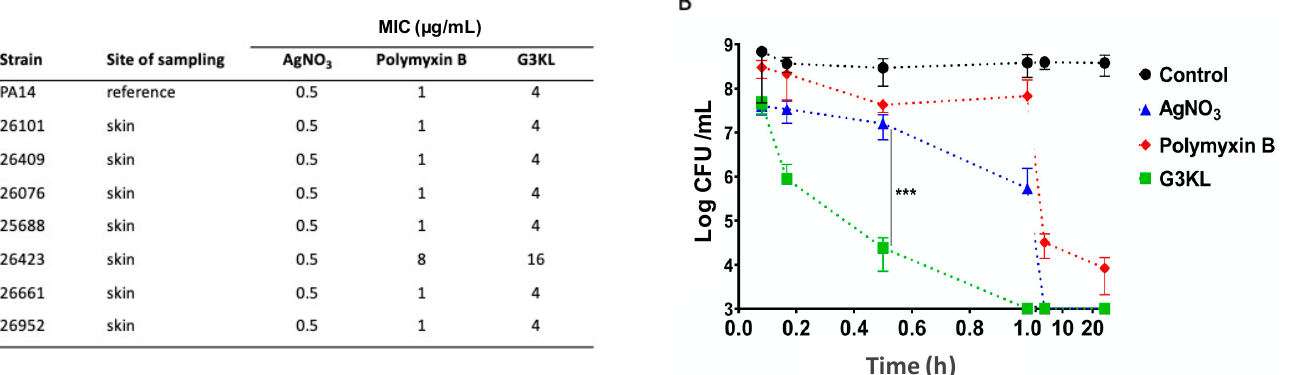
Figure 2. Antibacterial activity of G3KL. ( A ) Minimum inhibitory concentration of G3KL on clinical isolates and reference PA strain. ( B ) Time-kill assay of G3KL on PA14 reference strain. Silver nitrate and polymyxin B have been used as controls for bactericidal activity. Data are presented as the means ± SD ( n = 3). p values were determined by unpaired Student’s test. *** p ≤ 0.001.